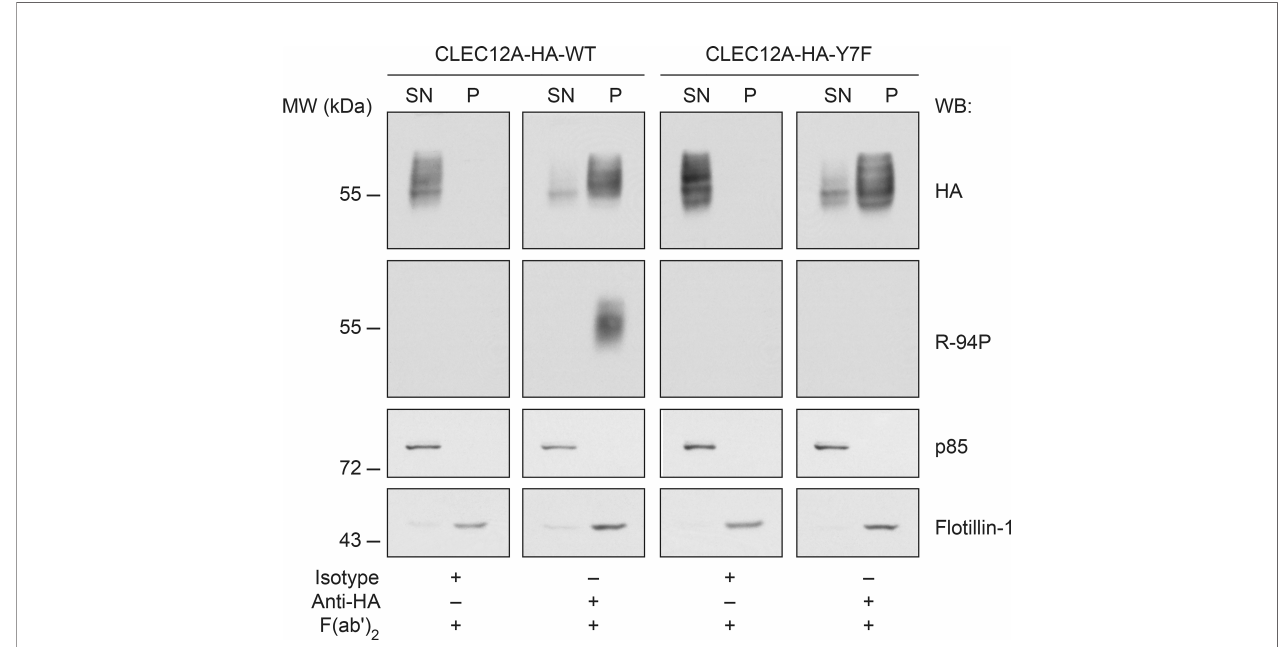
FIGURE 5 | CLEC12A is phosphorylated upon its antibody-induced translocation to the fl otillin-rich, detergent-insoluble cell pellet. Proteins in the fl otillin-enriched pellet ( P ) and supernatant ( SN ) of cell lysates of HEK-293T cells stably transfected with CLEC12A-HA-wt or CLEC12A-HA-Y7F after cross-linking with an anti-HA antibody were immunoblotted with an anti-HA, R-94P, anti-PI3K p85 subunit ( p85 ) or fl otillin-1 antibodies. The p85 protein was a loading control for proteins in the ( SN ) and fl otillin-1 for proteins in ( P ). Data are representative of 3 independent